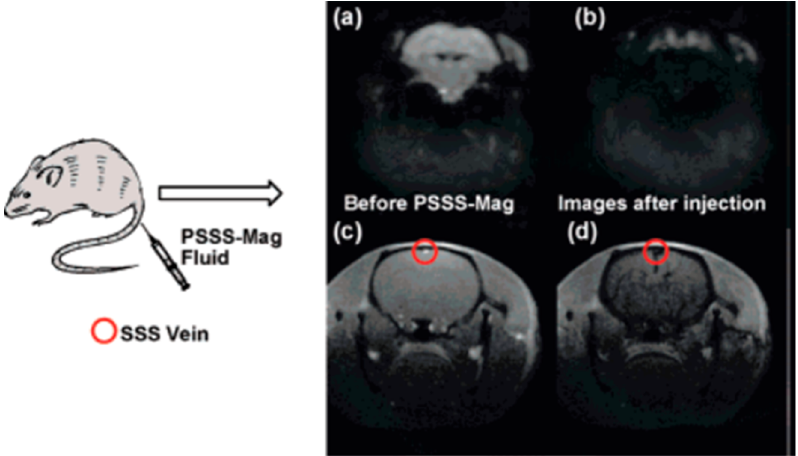
Figure 12. Echo planar image (EPI) of a mouse brain ( a ) before and ( b ) as PSSS-Mag1(Fe/Polysodium-4-styrene sulfonate ratio 1:2) travels across the organ; Fast Low Angle Shot (FLASH) picture of a mouse brain ( c ) before and ( d ) as PSSS-Mag1 travels across the organ. Reprinted with permission from S.